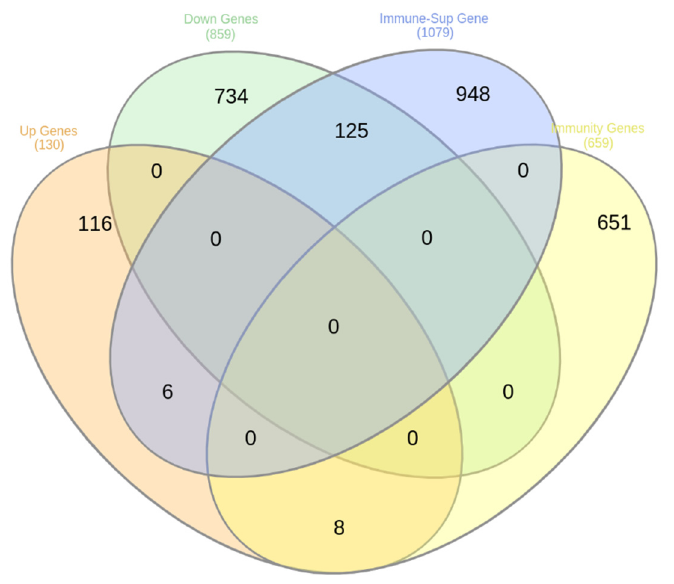
Figure 5. Venn diagram between DEGs of comparison-II with gene set-2 (immune suppressor) and gene set-1 immunity related genes.